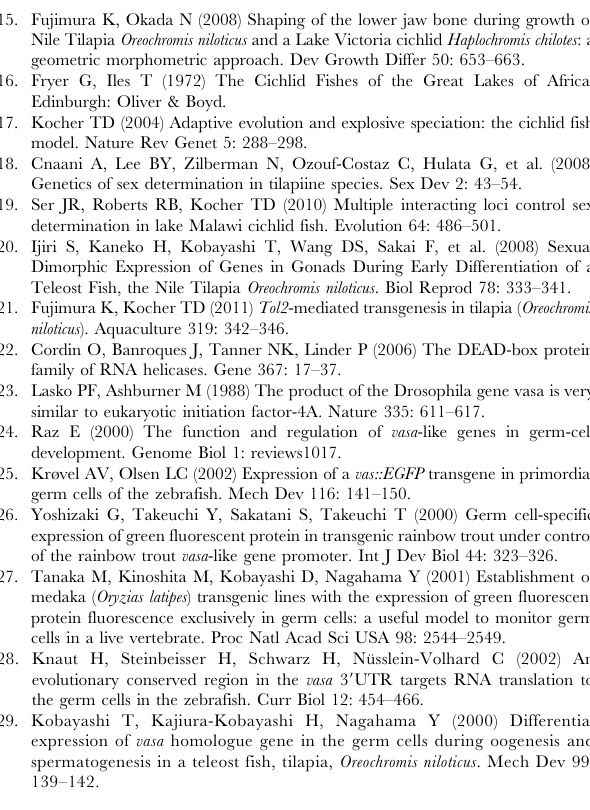
(arrow) are poorly matched. Figure S2 Comparison of vasa mRNA sequences to the BACs and genome scaffolds. (A) Dotplots of the vasa mRNA sequence (Genbank accession # AB032467 [29]) versus BAC 38M07 and genome scaffold_160. (B) vasa mRNA versus BAC 71H03 and genome scaffold_19. (C) vasa mRNA versus BAC 72C07 and genome scaffold_11. Note that all of the exons can be predicted in the comparisons of the mRNA to the BAC sequences, but that not all of the exons are predicted from the genome scaffolds. (TIF) Figure S3 Comparison of Nile tilapia 38M07 with draft genome assemblies of four East African cichlids. (A) Neolamprologus brichardi , (B) Astatotilapia burtoni , (C) Metriaclima zebra , (D) Pundamilia nyererei . Black arrow indicates the coding region of vasa gene. Boxes A–B and C–D correspond to those of Figures 5, 7, 8, S4 and S5. Dot-lined box indicates that the four cichlids are missing the B–C region and part of the C–D region. Black arrow indicates the coding region of vasa gene. (TIF) Figure S4 Sequences of the duplication boundaries. (A) 100 bp of 71H03 sequence flanking Box E–F. Red and green letters indicate a LINE of Expander and a DNA transposon of Tc1-like respectively, as shown in Figure S5. (B) 100 bp of 72C07 sequences flanking the left side of Box C–D and the right side of Box A–B. (C) 100 bp of 38M07 and 71H03 sequences flanking Box B–C. Blue arrows indicate a 6 bp motif of GCAAAC. Boxes A–B, C–D and E– F correspond to those of Figures 5, 7, 8, S3 and S5. (TIF)